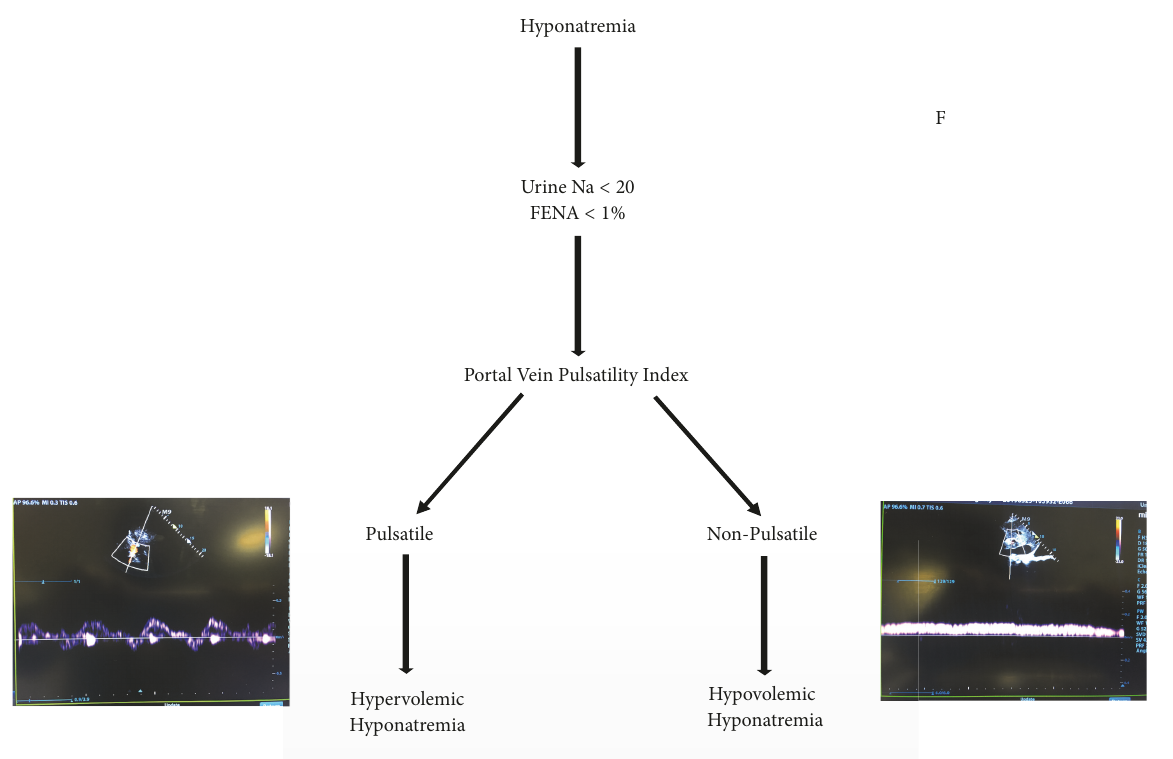
Figure 6: Proposed